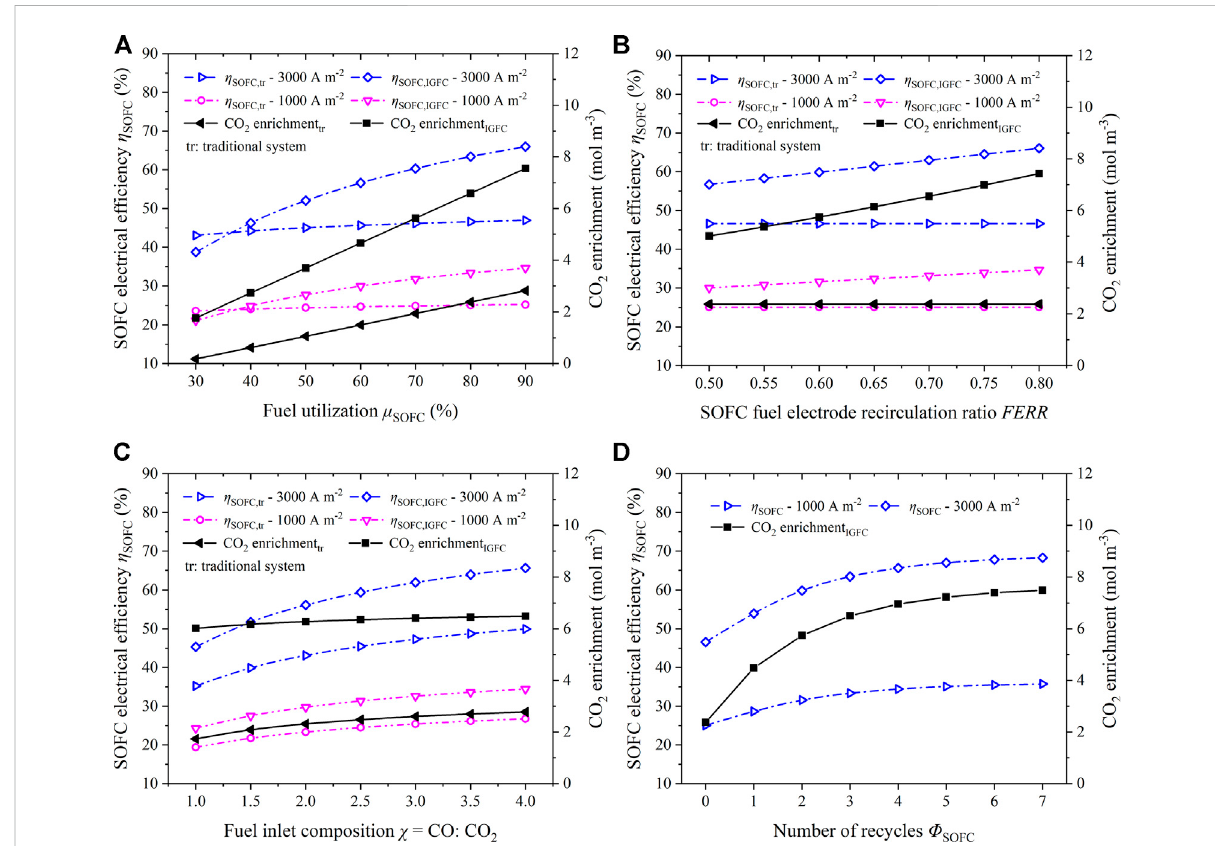
FIGURE 9 In fl uence of main parameters on CO 2 enrichment in SOFC and SOFC electrical ef fi ciency: (A) Fuel utilization μ SOFC ; (B) SOFC fuel electrode recirculation ratio FERR ; (C) Fuel inlet composition χ (cid:2) CO : CO 2 ; (D) Number of recycles Φ SOFC